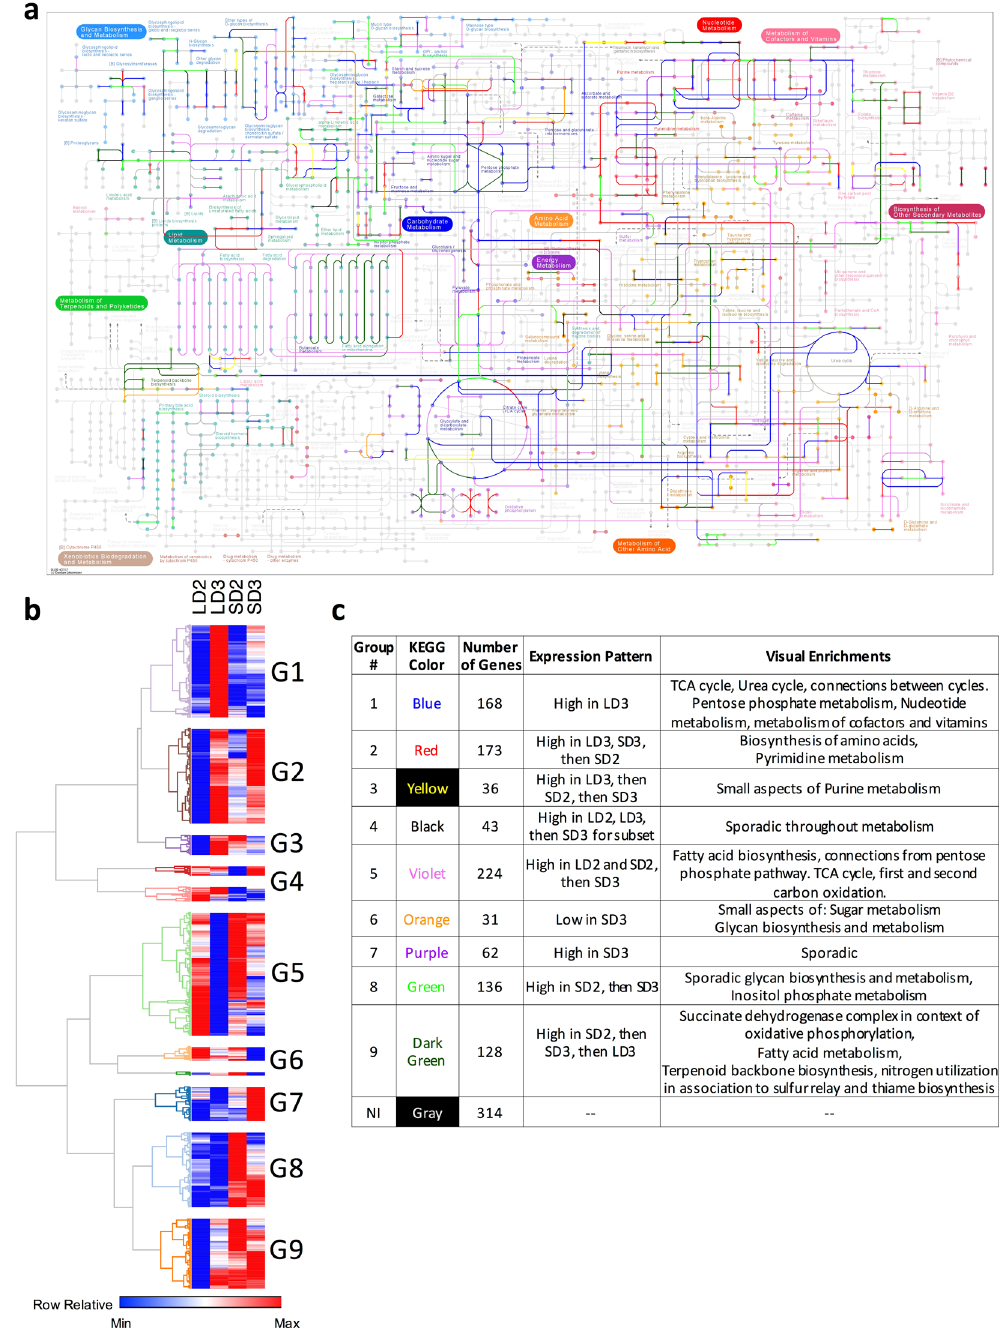
Figure 6. Overlay of gene clusters onto the KEGG primary metabolism for mice. Clusters were generated from gene expression during steroid and chemotherapeutic models of invasive pulmonary aspergillosis on day 2 and 3 post inoculation. Filtered, paired-end reads with a FPKM > 1 were ( b ) hierarchically clustered based on transcript expression. ( a ) Resultant groupings were color coded and overlaid onto the KEGG primary metabolism for mice 36 . ( c ) Summary table of identified groups: overlay color, number of genes in cluster, expression pattern, visual enrichments. Steroid Model, S; Chemotherapeutic Model, L; Day 2, D2; Day 3,